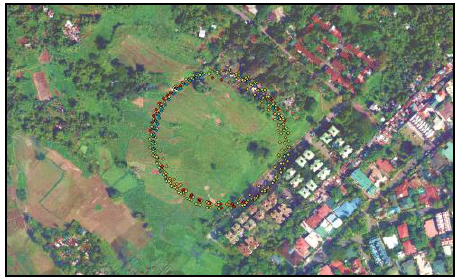
Figure 3. Experimental site: The area inside the circle which is approximately 2 hectares. (Source: UP Aerial